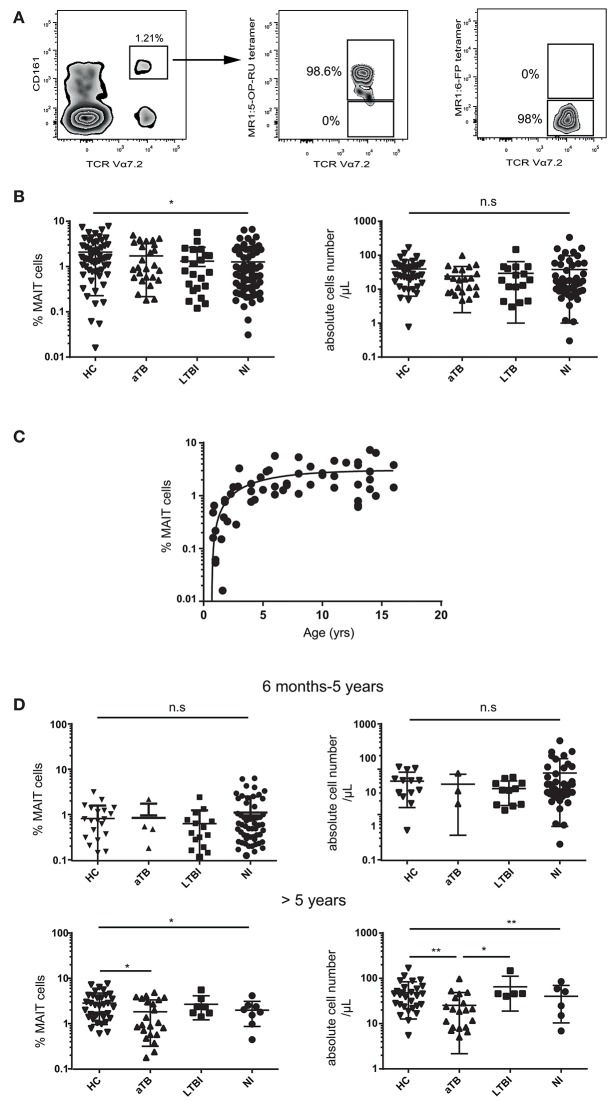
MAIT cell numbers are decreased in children with aTB over 5 years of age. (A) representative MAIT cell staining in a healthy child. Numbers indicate the percentage of Vα7.2+ CD161high MAIT cells (gated on live CD3+ CD4− T cells) (left panel) and the proportion of cells stained with the MR1:5-OP-RU tetramer (middle panel) or MR1:6-FP control tetramer (right panel). (B) statistical dot plots showing the percentages (left panels) and absolute numbers (right panels) of MAIT cells among CD3+ T lymphocytes in the whole children cohort. (C) relationship between log10-based transformed MAIT cell percentages and age in 58 healthy children aged 6 months to 16 years. (D) percentages and absolute numbers of MAIT cells in children 6 mo-5 years old (upper panel) and over 5 years (lower panels). Acute TB (aTB), latent TB infection (LTBI), exposed non-infected (NI) children, and healthy children controls (HC). Geometric means (horizontal bars) and statistical significance (Kruskall-Wallis test with post-hoc Dunn's test for multiple comparisons between all groups) are indicated. *P < 0.05; **P < 0.01; n.s, not significant.